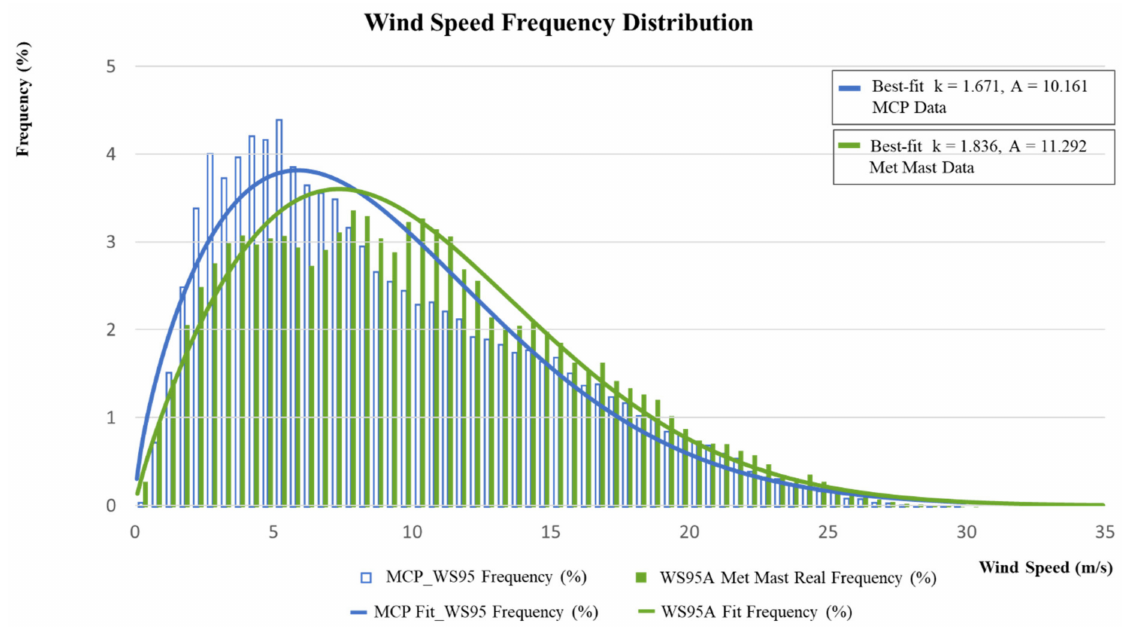
Figure 12. Weibull distributions of wind speed by offshore met mast and MCP.